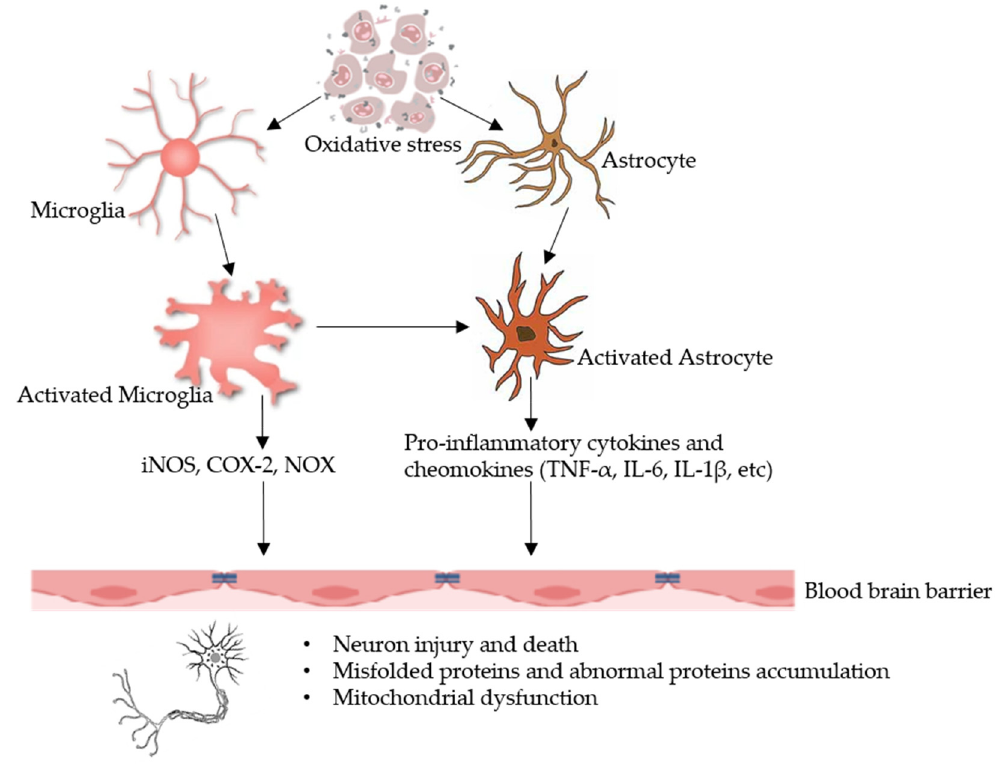
Figure 1. The oxidative stress leads to neuroinflammation and neurodegenration. In homeostatic conditions, astrocytes release antioxidants by degrading reactive oxygen species, uptake and metabolism of neurotransmitters, provide energy and neurotrophin. In pathological conditions, astrocytes could be activated via stimulation from activated microglia. Therefore, high levels of oxidative stress activate signalling pathways that activate microglia and astrocyte (major glial inflammatory characters). Pro-inflammatory factors secreted by glial cells induce a neuroinflammatory response that disrupts the blood brain barrier’s integrity and infiltrates into the brain, secreting factors that lead to neurodegeneration, in which the most characteristic feature is neuron injury and death. iNOS: inducible nitric oxide synthase, COX-2: cyclooxigenase-2, NOX: NADPH oxidase, IL: interleukin, TNF- α : tumor necrosis factor